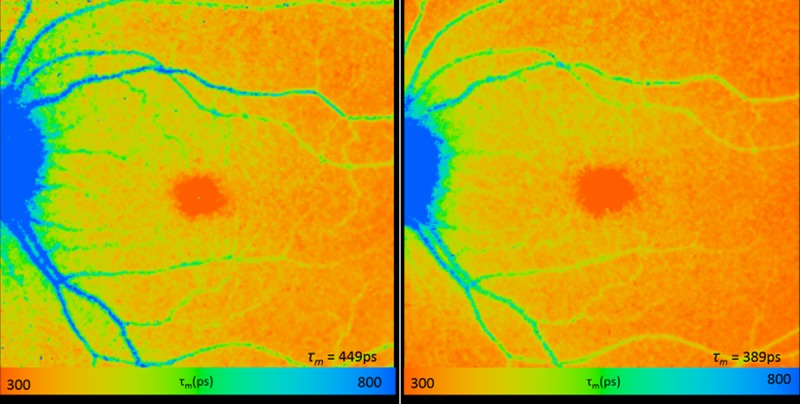
Fluorescence lifetime image of short spectral channel under non-dilated (left) and dilated (right) settings in same subject.Note that the longer lifetime pixels (green to blue in color) found in the more peripheral regions in the non- dilation setting compared to the dilated setting, and the overall longer τm (τm = 449 ps in without dilation, τm = 389 ps with dilation).